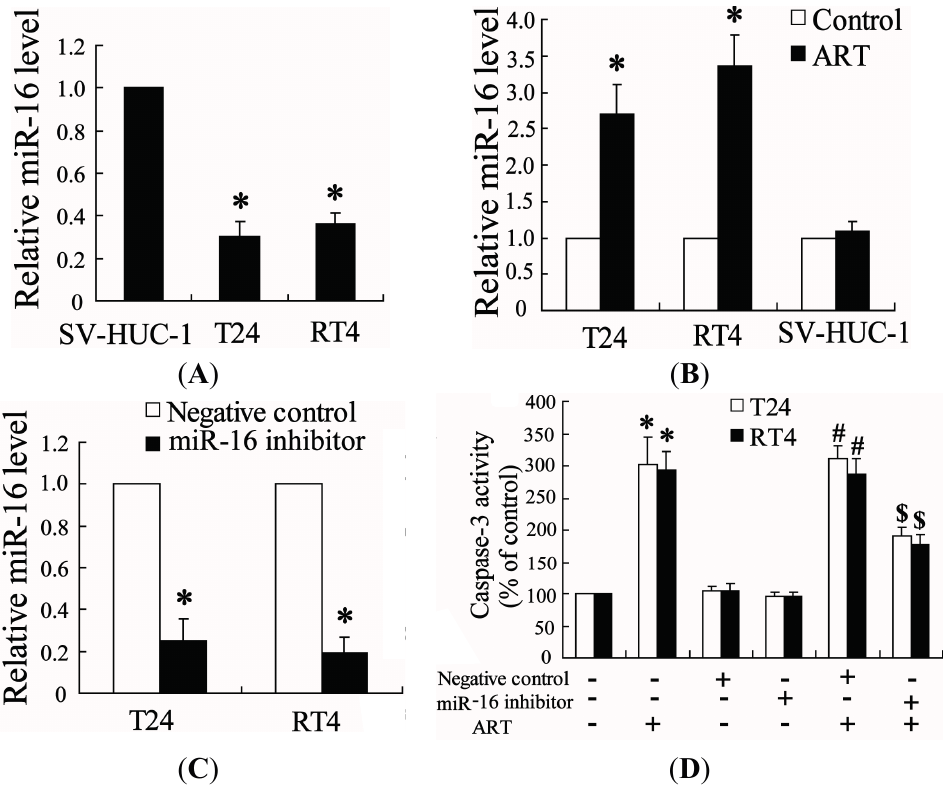
Figure 4. Down-regulation of miR-16 can reverse the effect of ART on apoptosis of bladder cancer cells. The level of miR-16 was measured in T24, RT4 and SV-HUC-1 cells. * p < 0.05, compared to SV-HUC-1 cells ( A ); The expression of miR-16 was detected in T24, RT4 and SV-HUC-1 cells treated with ART for 24 h. * p < 0.05, compared to vehicle ( B ); After transfection with miR-16 inhibitor for 24 h, T24 and RT4 cells were added with ART for an additional 24 h, and then the level of miR-16 was detected. * p < 0.05, compared to negative control ( C ); After transfection with miR-16 inhibitor for 24 h, T24 and RT4 cells were added with ART for an additional 48 h, and then caspase-3 activity was measured. * p < 0.05, compared to vehicle controls group. # p < 0.05, compared to negative